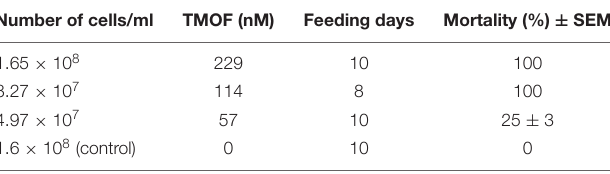
TABLE 3 | Feeding of industrial fermented P. pastoris KM71H- tmf A to Ae. aegypti Larvae. Number of